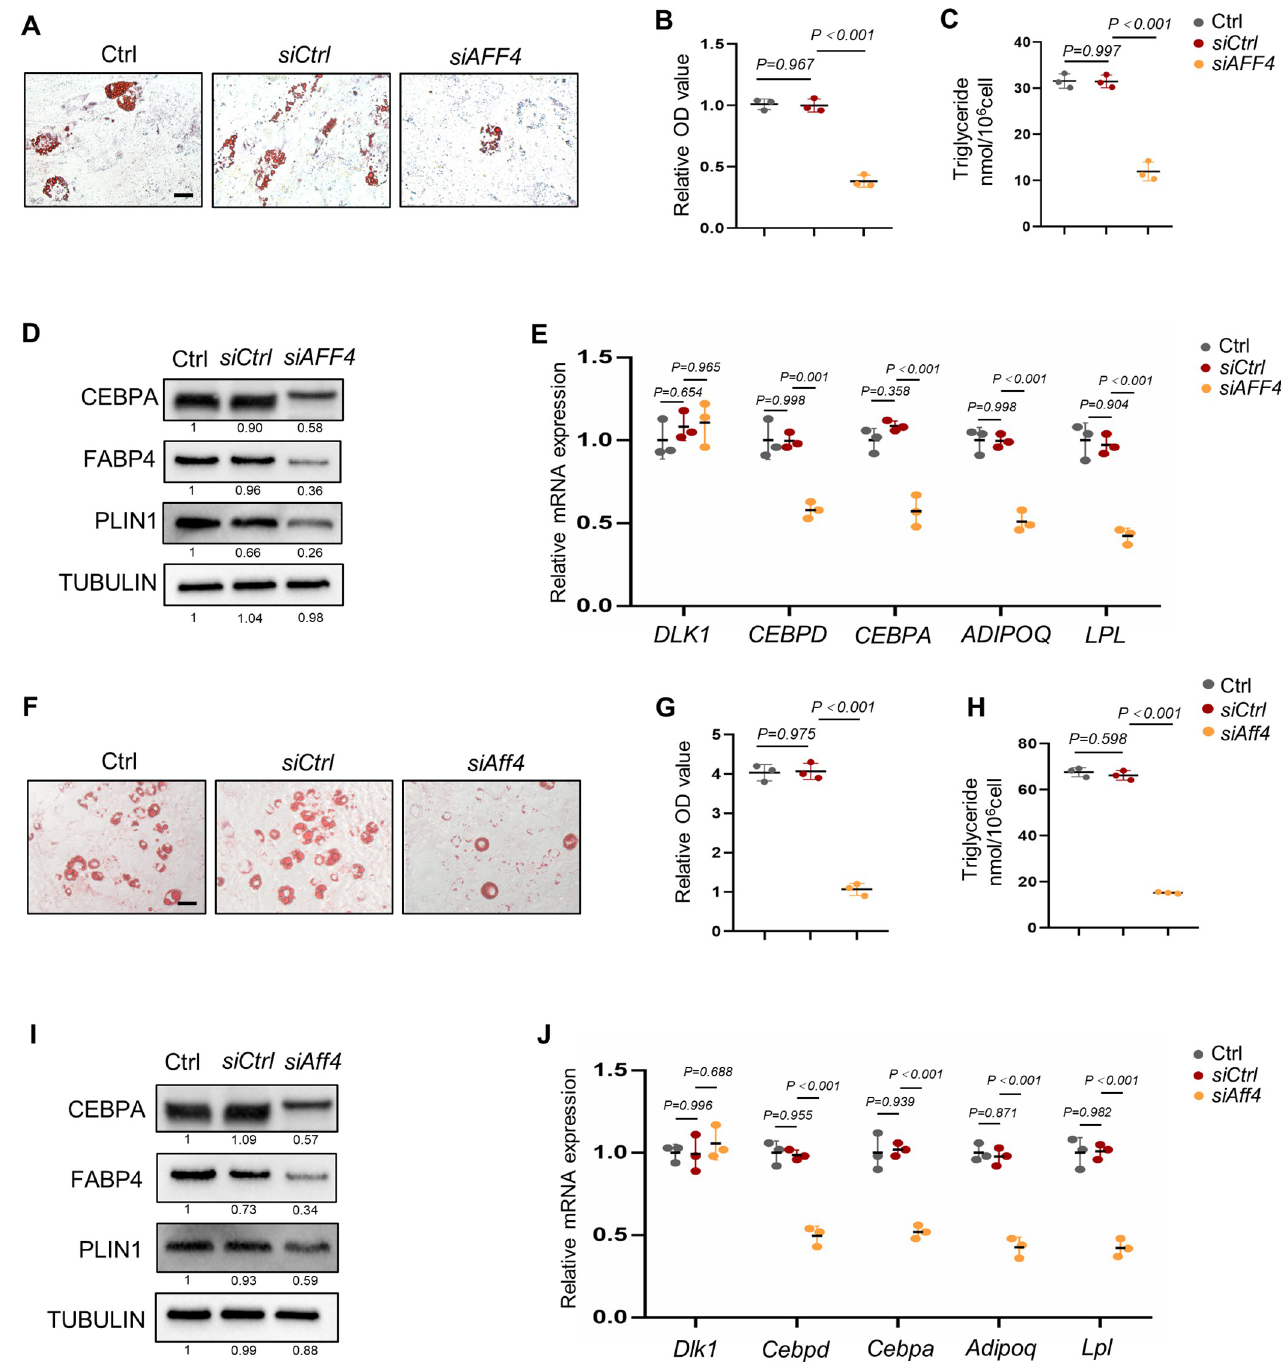
Fig 1. Depletion of AFF4 inhibits adipogenic differentiation (A-E) Adipogenic differentiation in AFF4-deficient hMSCs. (A) Representative images of oil red o staining. Scale bar, 25 μ m. (B) Absorbance of lipids at 518 nm. n = 3. (C) Triglyceride quantification. n = 3. (D) Western blot analysis of the expression of adipogenic markers. (E) RT-qPCR of adipogenic markers. n = 3. (F-J) Adipogenic differentiation in AFF4-deficient 3T3-L1 cells. (F) Representative images of oil red o staining. Scale bar, 25 μ m. (G) Absorbance of lipids at 518 nm. n = 3. (H) Triglyceride quantification. n = 3. (I) Western blot analysis of the expression of adipogenic markers. (J) RT-qPCR of adipogenic markers. n = 3. All quantified data are presented by as mean ± SD. The P values were calculated by one-way ANOVA with Tukey’s post hoc test.